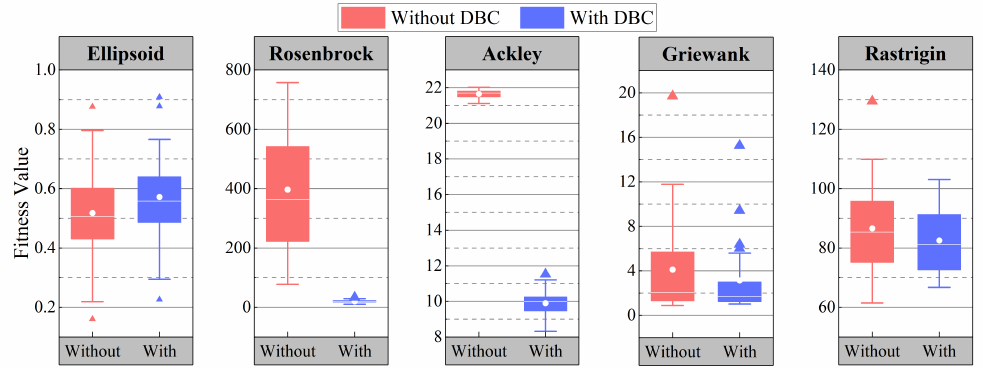
Figure 8. The fitness of five benchmarks with or without